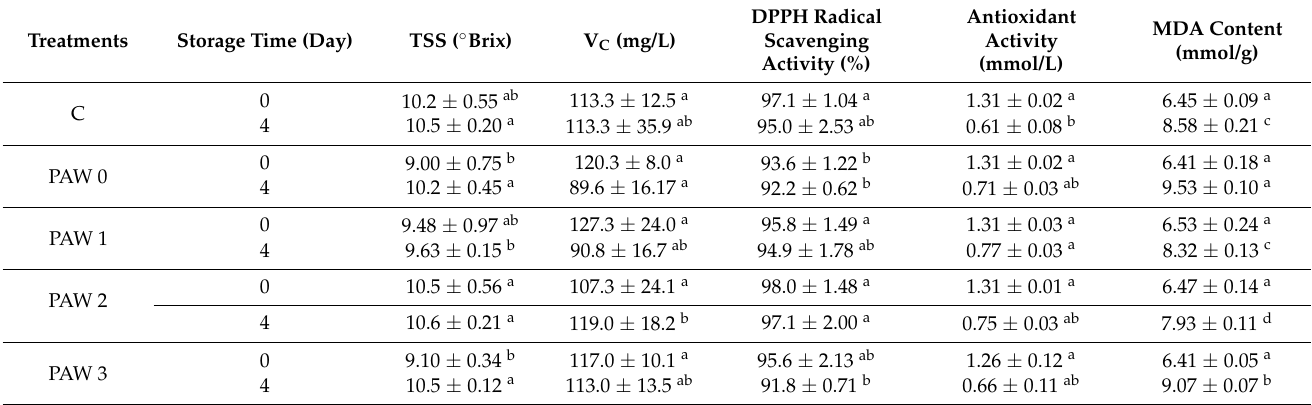
Table 2. Nutritional quality changes of strawberries in different treatment groups during